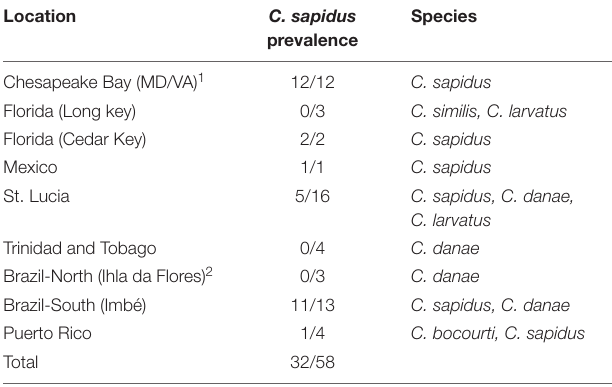
TABLE 2 | Species composition of Callinectes spp. crabs across sample locations based on sequencing of 12S rRNA